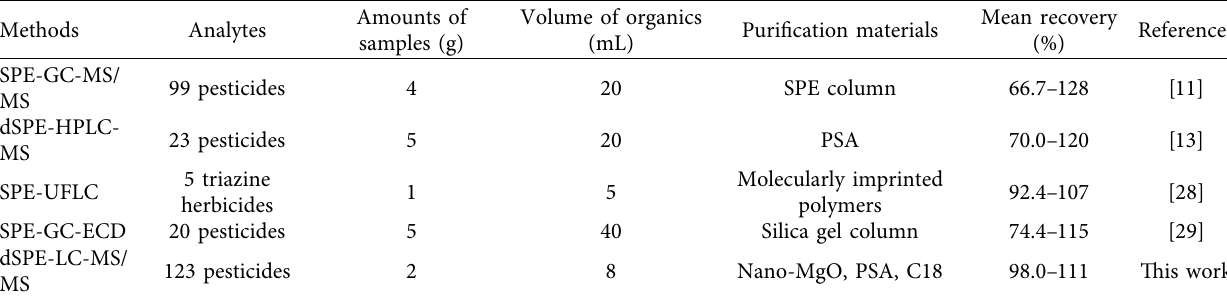
Figure 5: Comparison of recovery (a) and matrix effect (b) of the developed method with the traditional QuEChERS method for pesticides analysis of PRA-ZJ sample. Table 2: Comparison of method performance with the reported method for analysis of Paeoniae Radix Alba